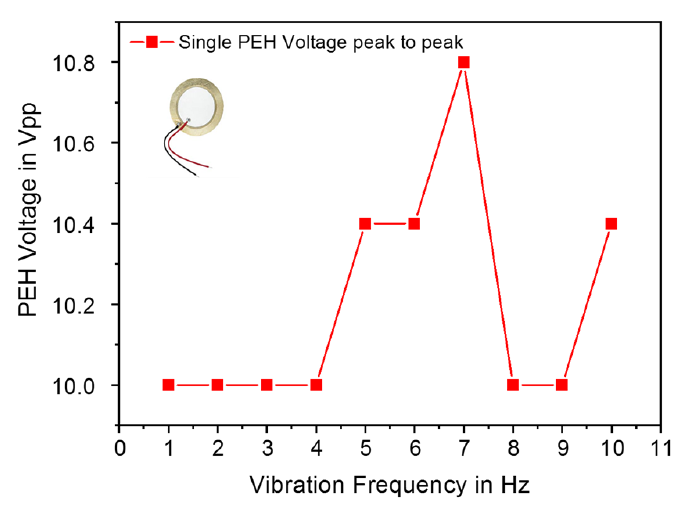
Figure 9. Piezoelectric Harvester open circuit voltage versus frequency